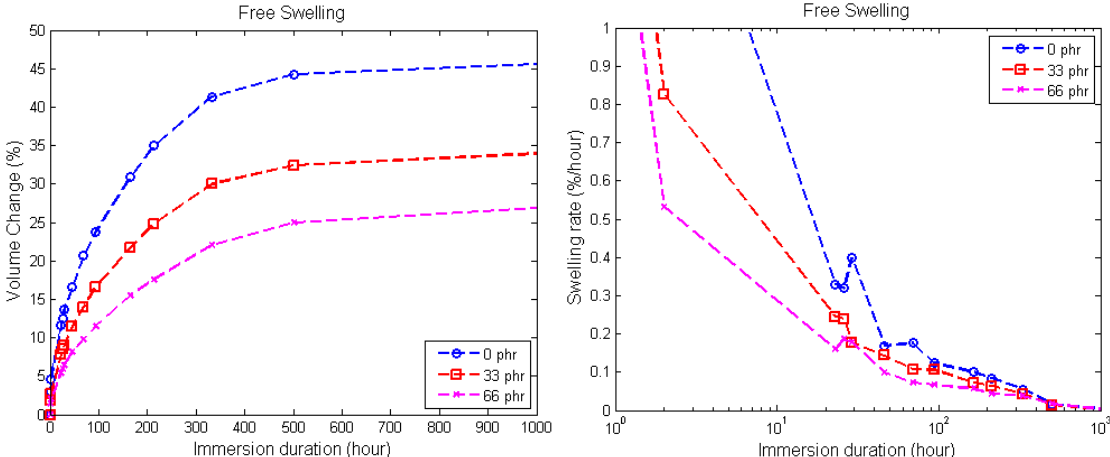
Figure 4. Volume change undergone by the specimens with different carbon black contents ( a ) and the corresponding rates of swelling ( b ).